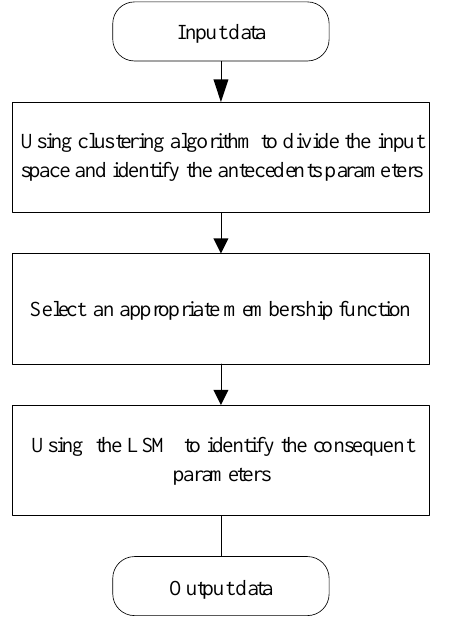
Figure 2. Identification process of the T-S fuzzy model.